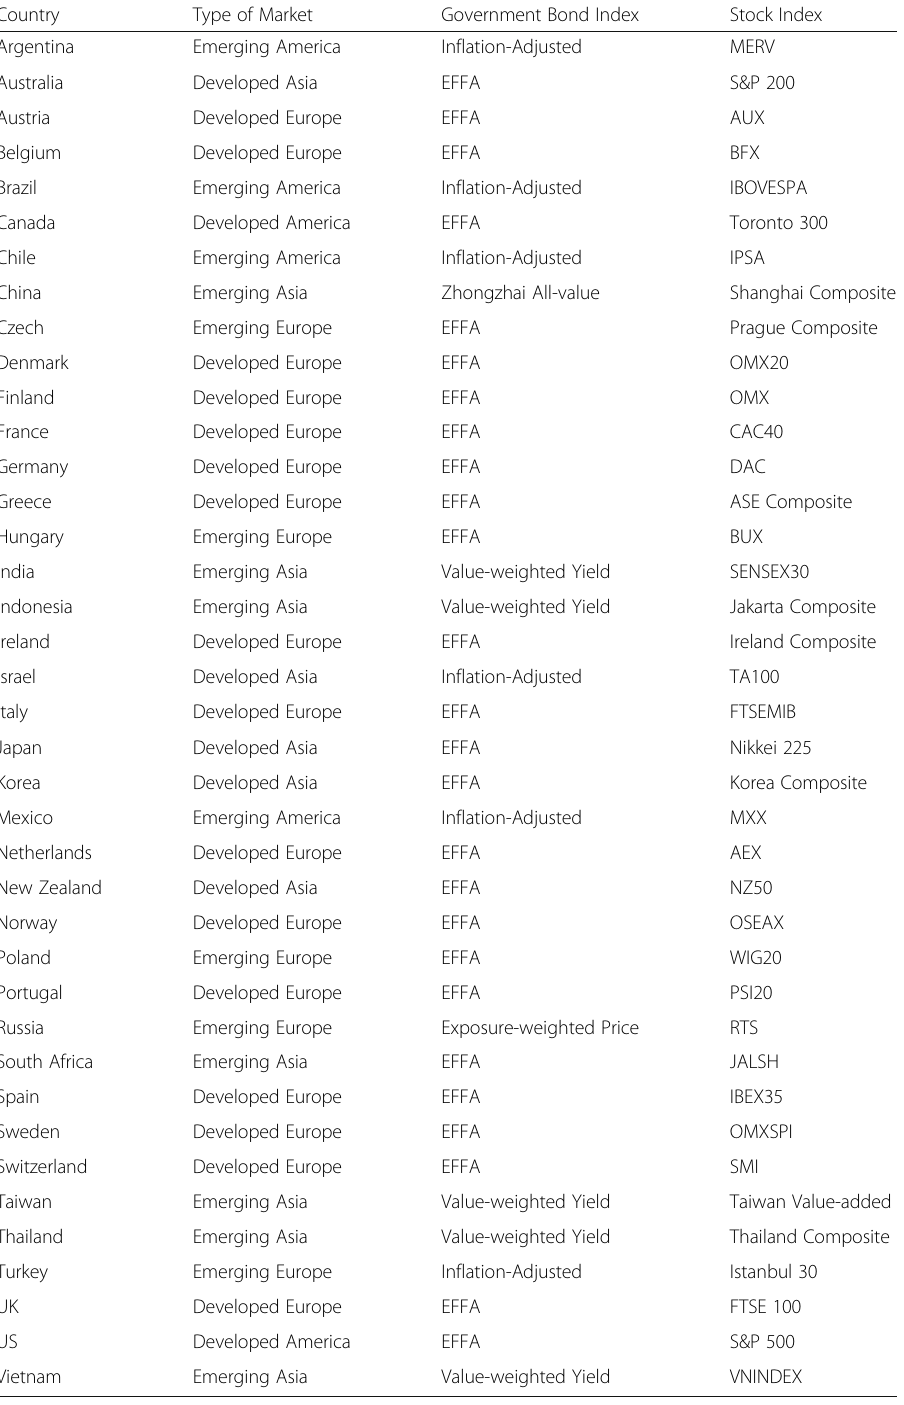
Table 2 List of the stock and government bond indices